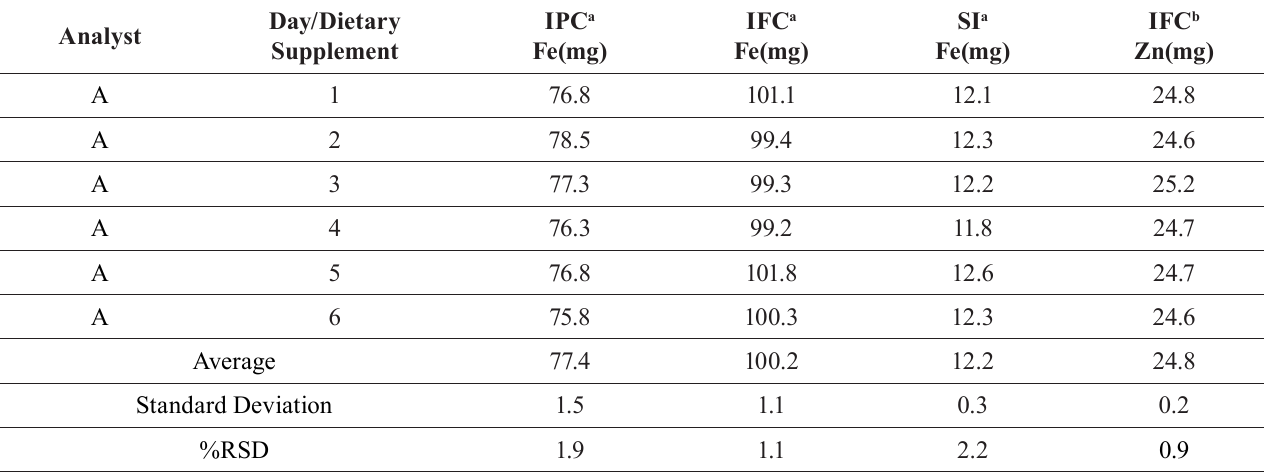
TABLE IX - Intermediate precision results for the investigated dietary supplements (Delay time =5 s, Measurement Time=5 s, n=9 times, A=Same